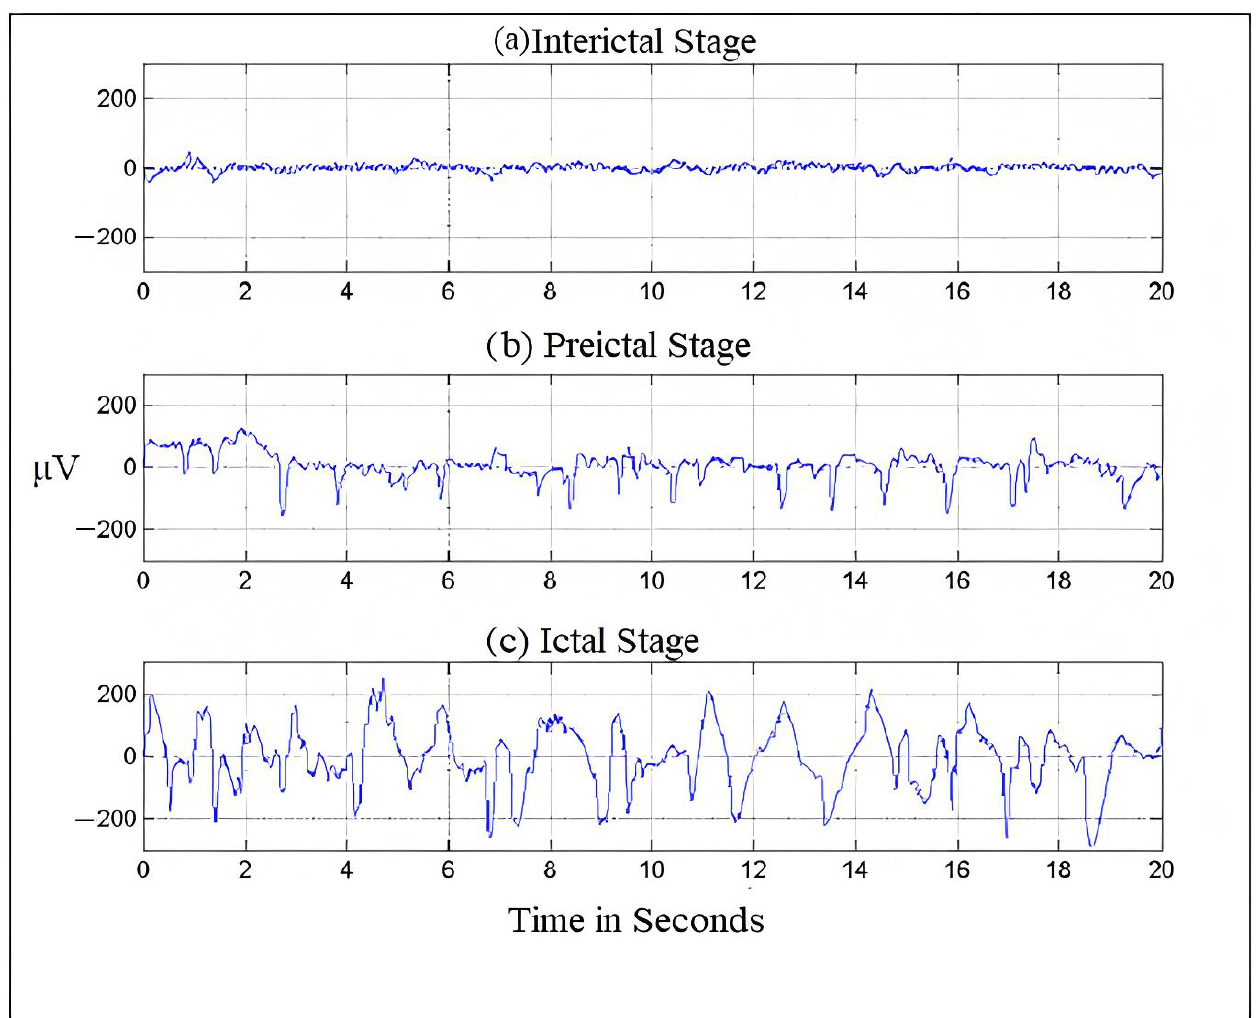
Figure 1. Brain- activity is recorded during different seizure stages.